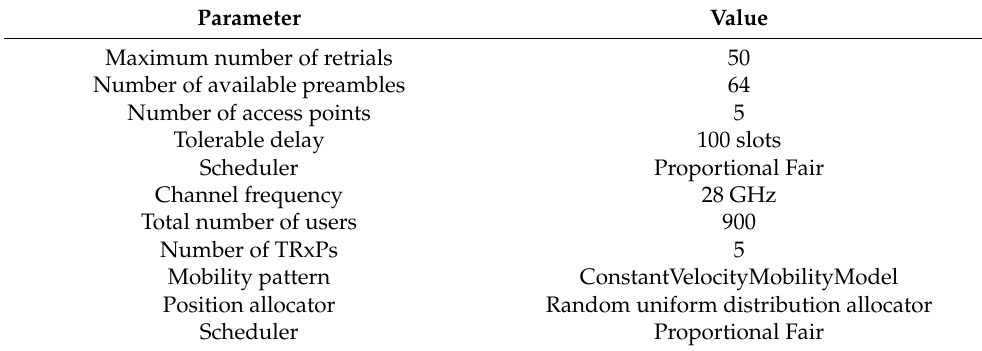
Table 1. Simulation parameters.